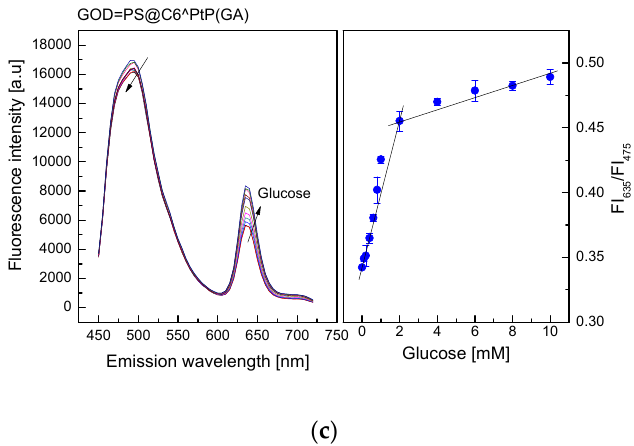
Figure 5. Response of GOD = PS@C6^PtP membrane using ( a ) EC, ( b ) D4, and ( c ) GA as supporting materials at different glucose concentrations and calibration curve for glucose as determined by ratio of FI 635 /FI 475 .